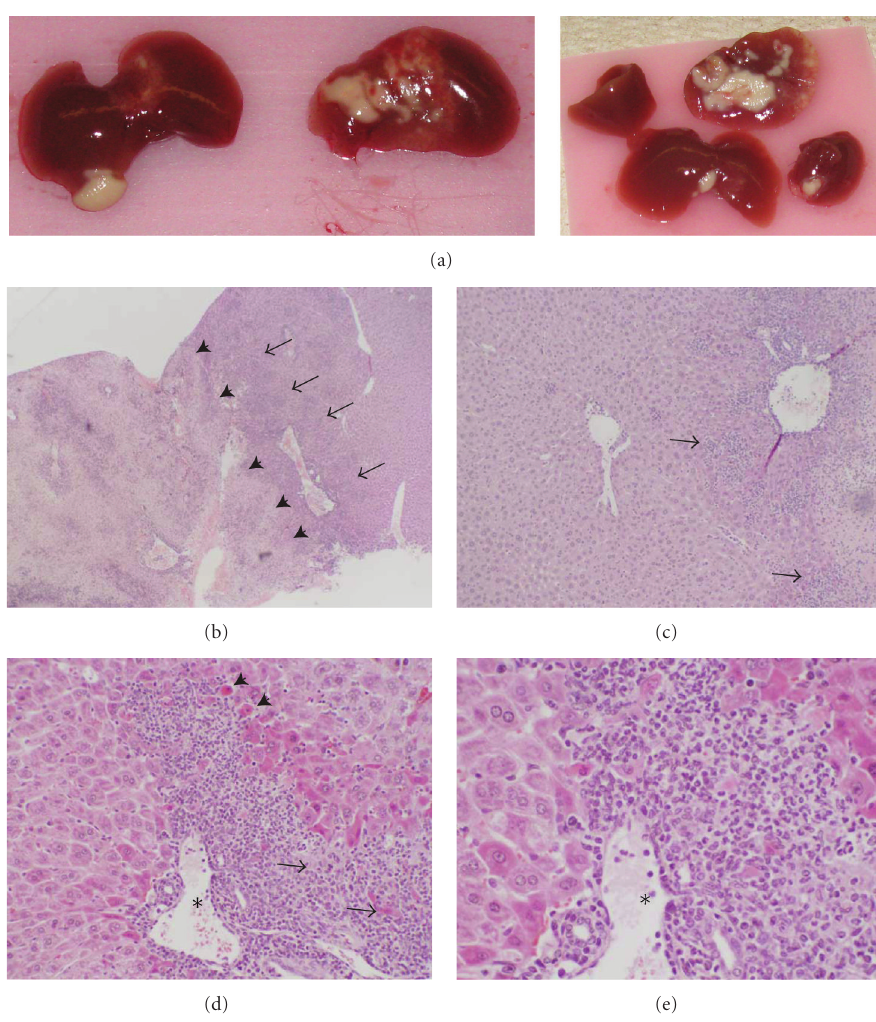
Figure 1: Baseline liver lesions in Myd88-INFAR double-KO mice. (a) White lesions on the surface of multiple liver lobes from two male Myd88-IFNAR double-KO mice (8 weeks old), detected at the time of laparotomy. Una ff ected areas of the liver have a normal appearance. Para ffi n-embedded liver tissue sections (6 μ m) of abnormal livers were stained with hematoxylin and eosin and digitally captured at 40x (b), 100x (c), 200x (d), and 400x (e) magnification. (b) Large areas of hepatocellular necrosis across the liver lobes (indicated by arrowheads) are surrounded by layers of hepatocytes with eosinophilic cytoplasm and dense inflammatory cell infiltrates (indicated by arrows). Adjacent liver tissue within the same lobe looks normal. (c) Layers of hepatocytes with eosinophilic cytoplasm in zones I and II of the hepatic lobule, with dense inflammatory cell infiltrates (arrows). (d) and (e) Details of zone I of a hepatic acinus showing a dense inflammatory reaction composed of lymphocytic and polymorphonuclear cells. The inflammatory infiltrate encloses hepatocytes undergoing coagulative necrosis (arrows) and a portal vein with histological features of endothelitis (asterisk). The hepatocytes that surround the inflammatory infiltration have an altered cell shape, increased eosinophilia, and some show pyknotic nuclei suggestive of apoptosis